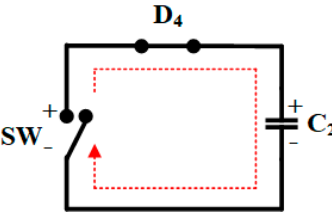
Figure 8. HG-SIQBC—equivalent circuit to find the voltage stress across the switch. (The current flow is given in dotted lines).